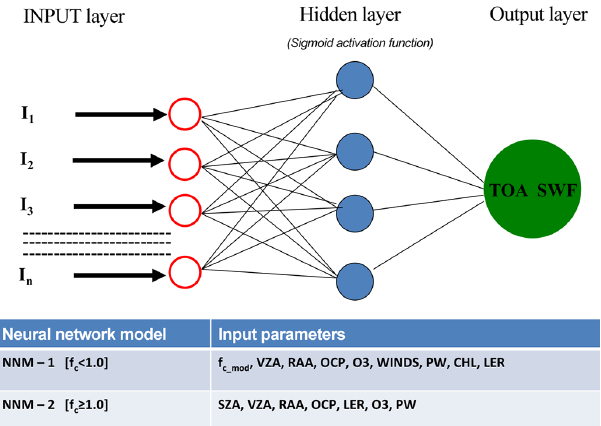
Figure 3. A schematic of the neural network model used for esti- mation of TOA SW flux with OMI UV retrieved parameters. The table in the bottom lists all the input parameters corresponding to two NN models